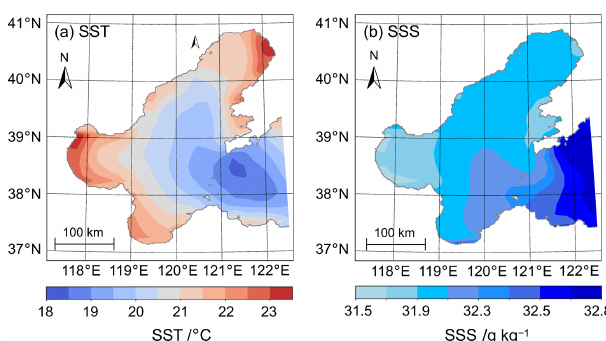
Figure 2. Examples of (a) an initial sea surface temperature (SST) field and (b) an initial sea surface salinity (SSS) field interpolated from the global ORCA025 model simulation on 1 July